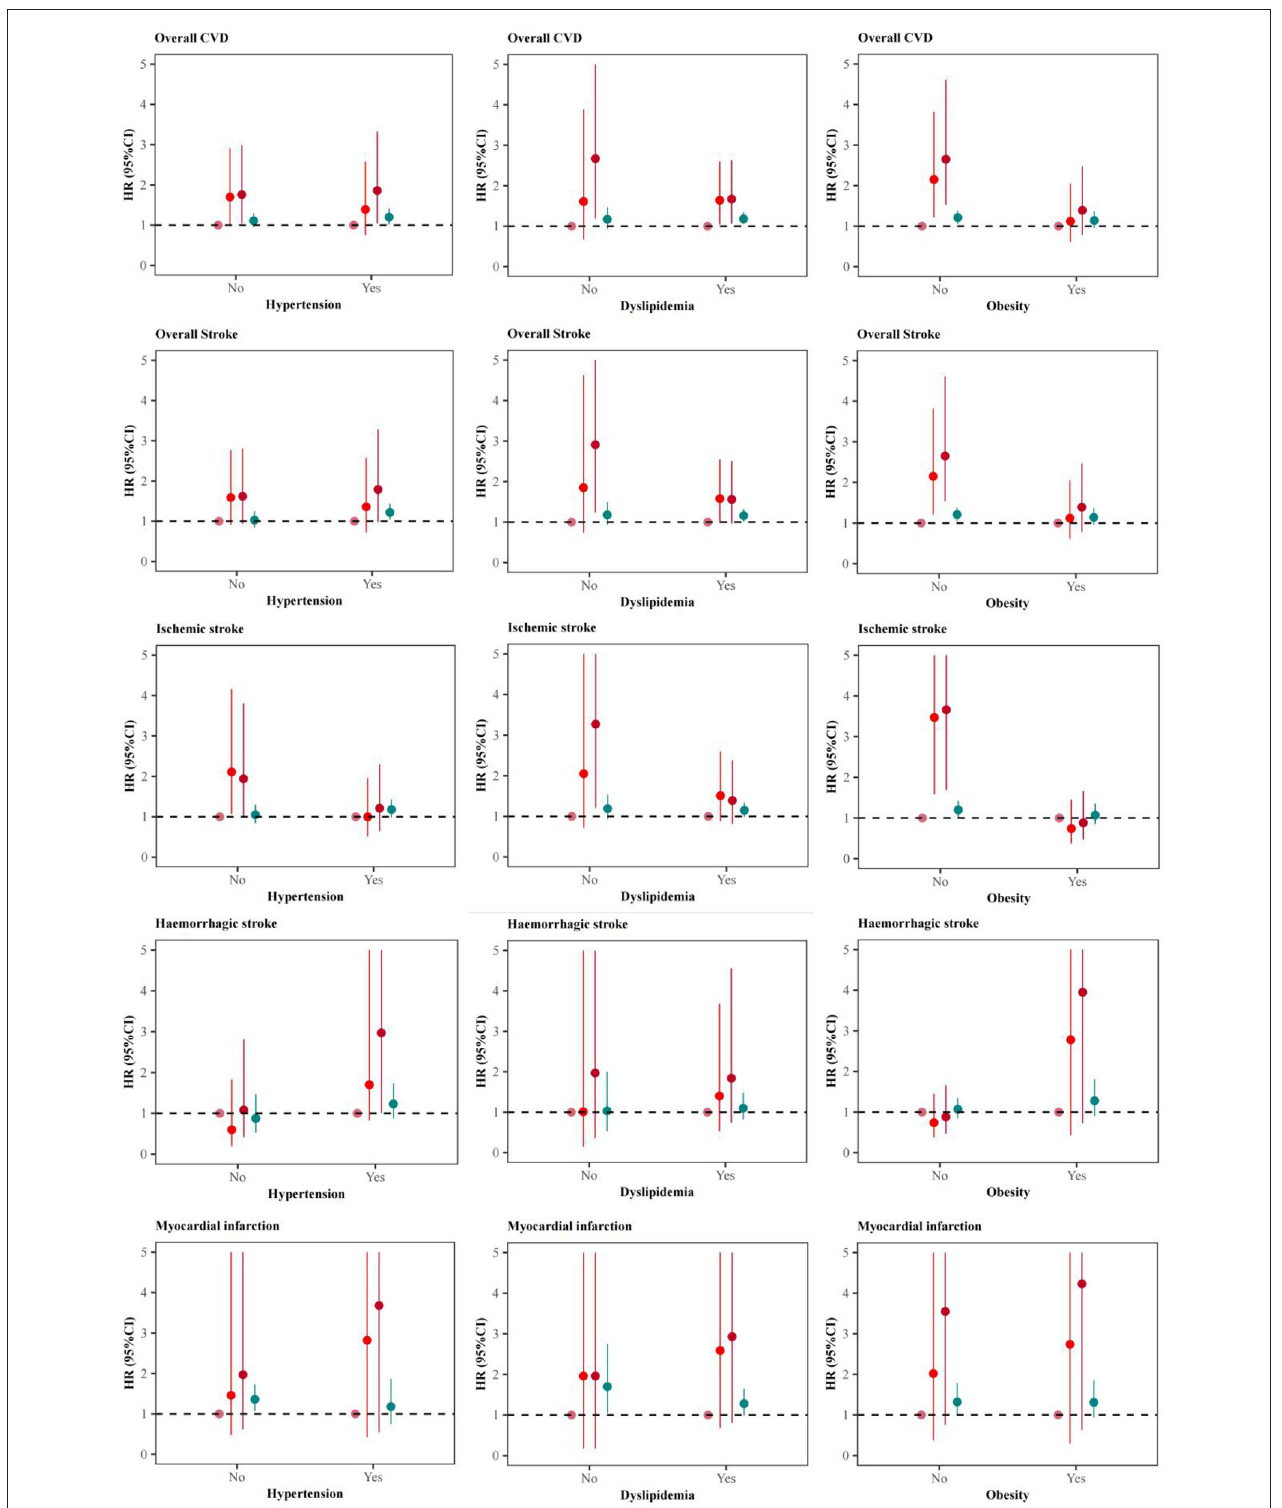
FIGURE 4 | Adjusted hazard ratios (HRs) and 95% confidence intervals (95%CIs) for cardiovascular diseases (CVD) associated with baseline 2-h postload glucose (2h-PG) varied by status of hypertension, dyslipidemia or obesity.